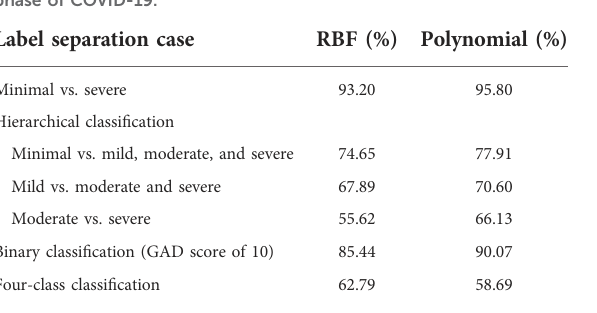
TABLE 3 Alternative kernels classi fi cation per test case for the fi rst phase of COVID-19. Label separation case